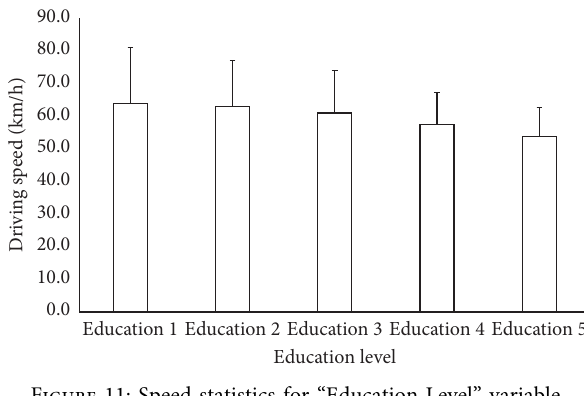
Figure 11: Speed statistics for “Education Level”